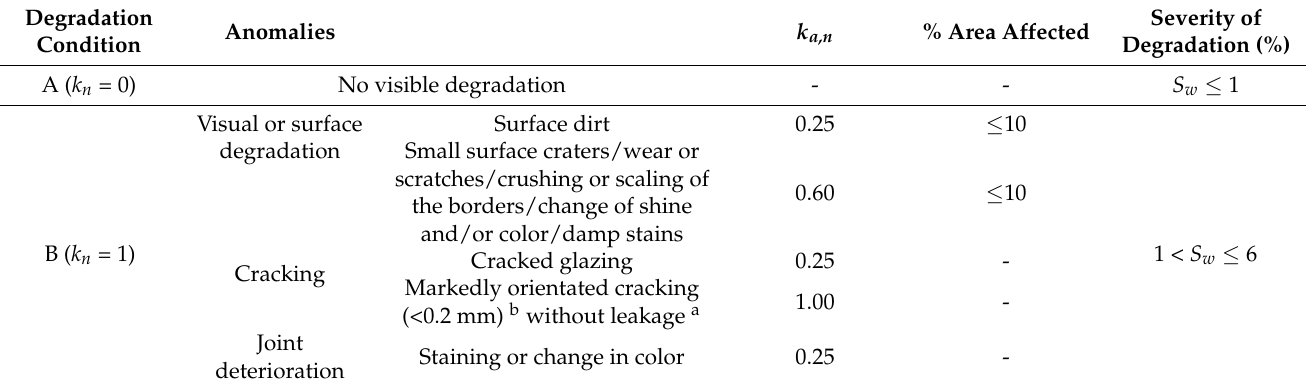
Table A1. Classification system for ceramic tiling systems (CTS)